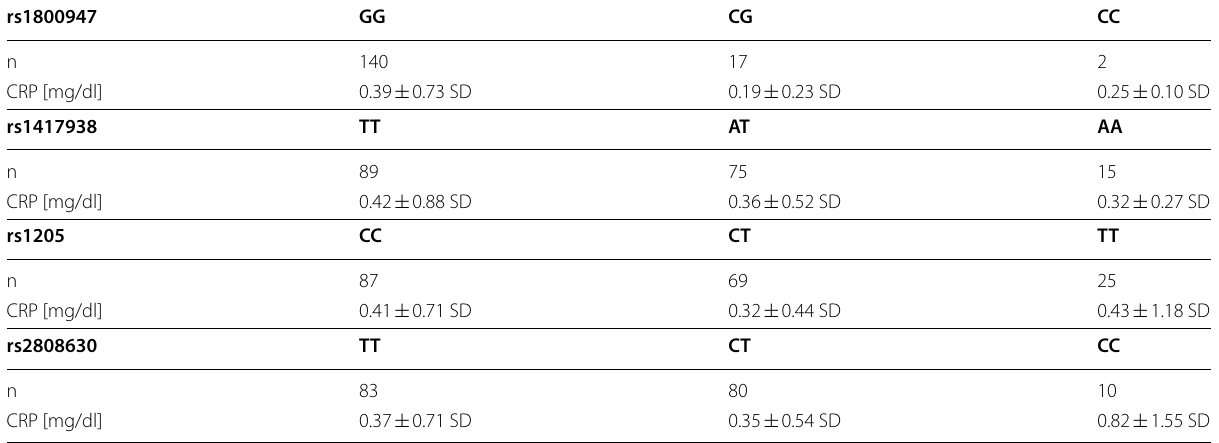
Genotype distribution of the 4 investigated SNPs in the whole sample is displayed as well as mean CRP concentration CRP C-reactive protein, n number, SD standard